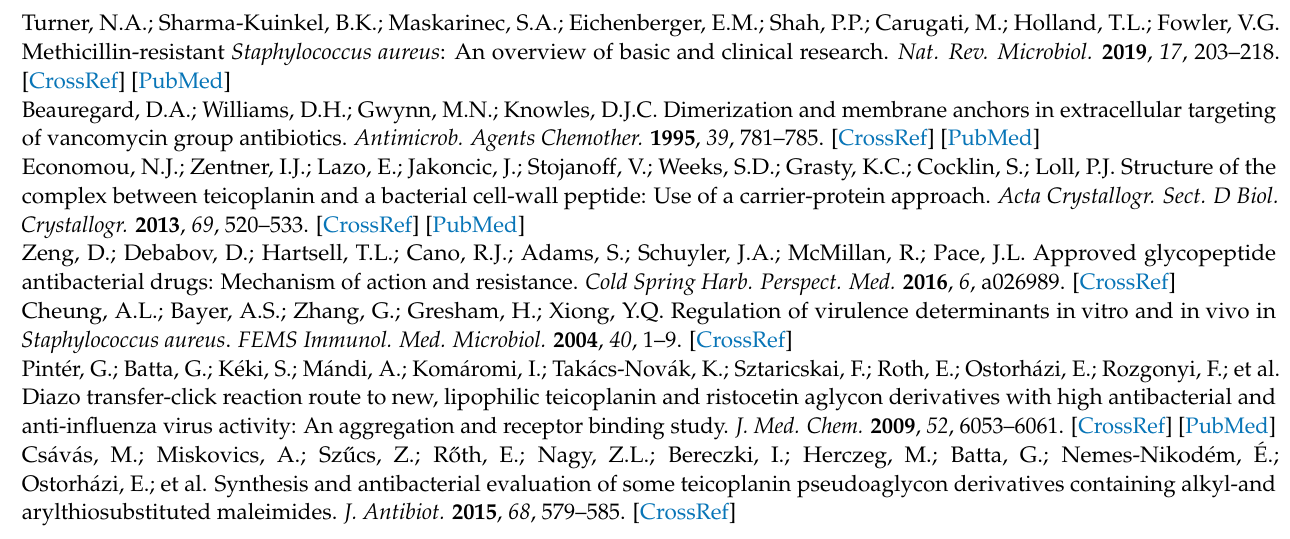
Table S1: MICs of the antibiotics against wild-type (WT) Staphylococcus aureus strains and mutants selected in resistance selection